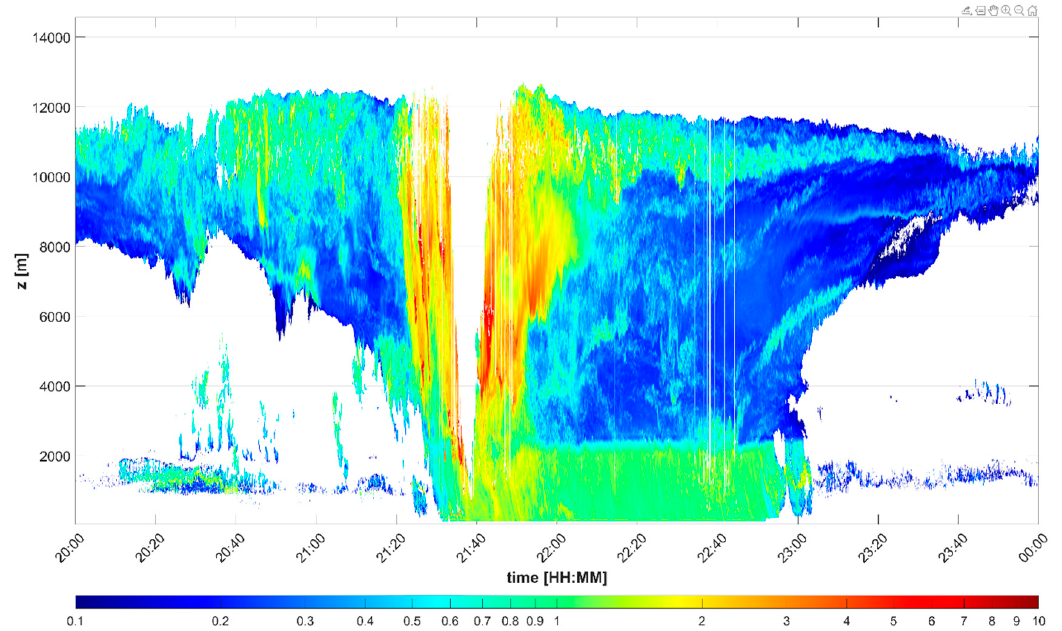
Figure 7. Doppler spectrum width ( σ [m / s]) during the thunderstorm on 10 June 2019 from 20 to 24 h UTC at the Milešovka observatory. Note that the color bar is in logarithmic scale and that y-axis (z [m]) displays the height in meters above the cloud radar situated at an elevation of 837 m a.s.l.